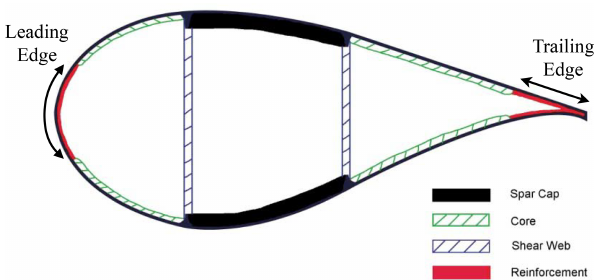
Figure 9. AutoNuMAD framework.